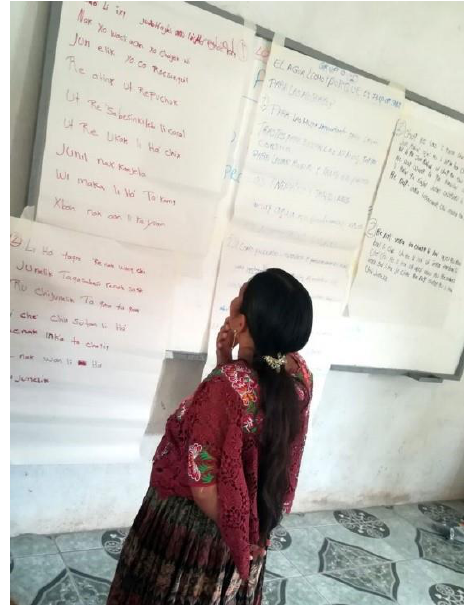
Figure 5. Collaborative workshop with women elders about water’s significance (credit: Lieselotte Viaene, 2017).